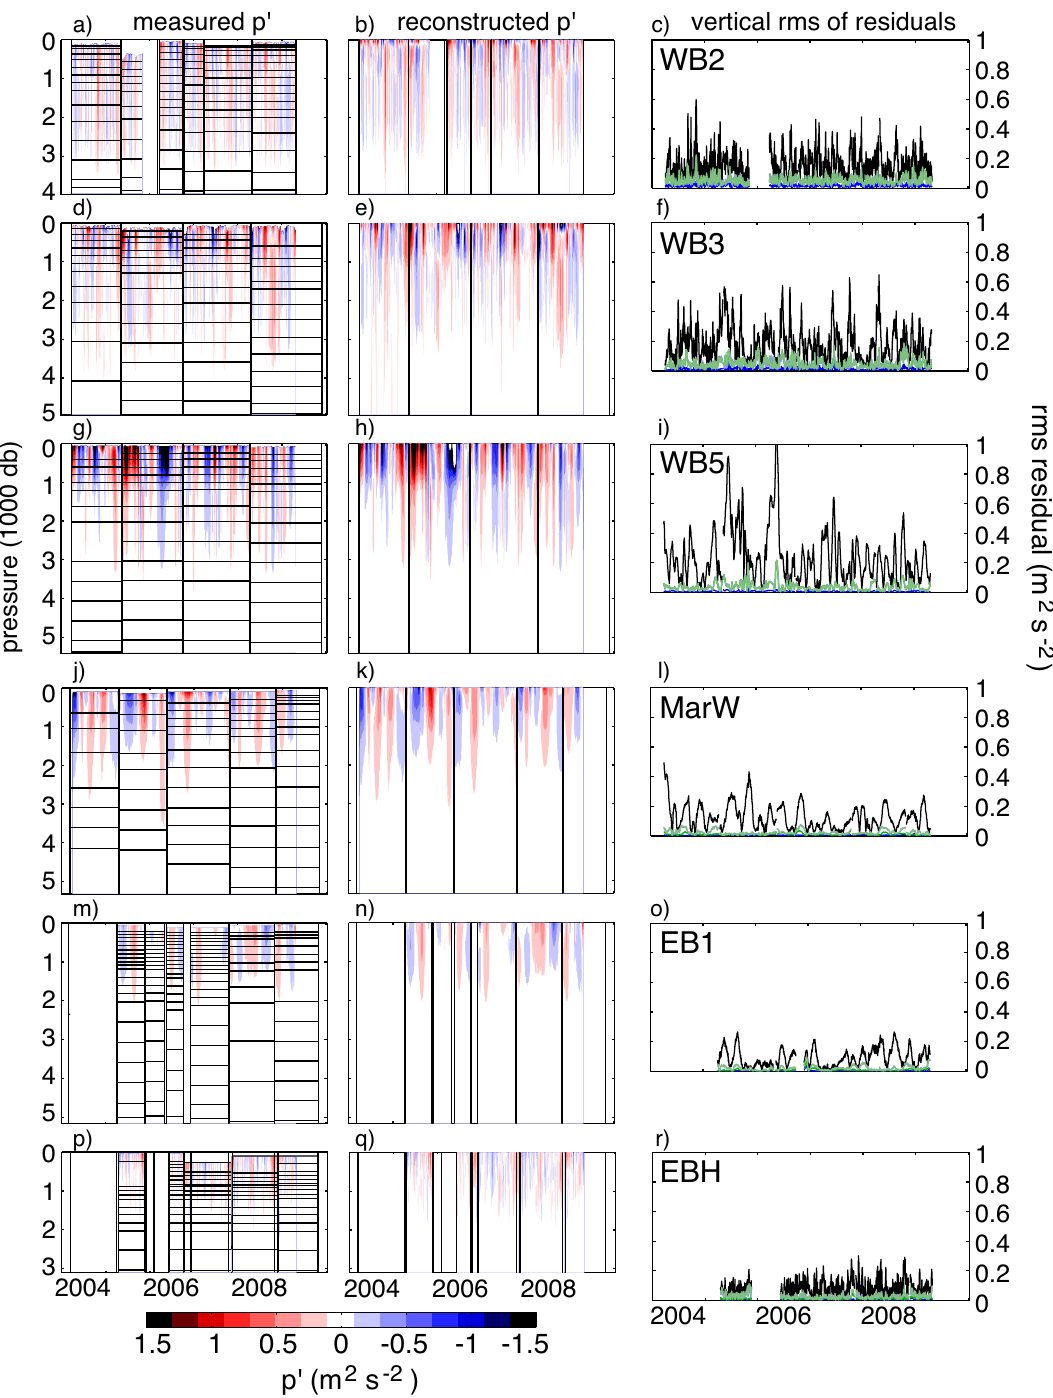
Fig. 4. Reconstructions for all moorings. (left column) The original p 0 reduced pressure perturbation (in color), with median instrument depths (horizontal black lines) over each deployment. (center column) The reconstructed p 0 using all 5 flat-bottomed modes. (right column) The vertical rms of the original signal (black), and the vertical rms residual of the reconstructed signal using all flat-bottomed modes (blue), using M = 2 flat-bottomed modes (light blue, obscured by green line), and using M = 2 KB modes (green). The rows from top to bottom are for moorings WB2, WB3, WB5, MarWest, EB1, and EBH. Each mooring deployment is delineated with vertical black